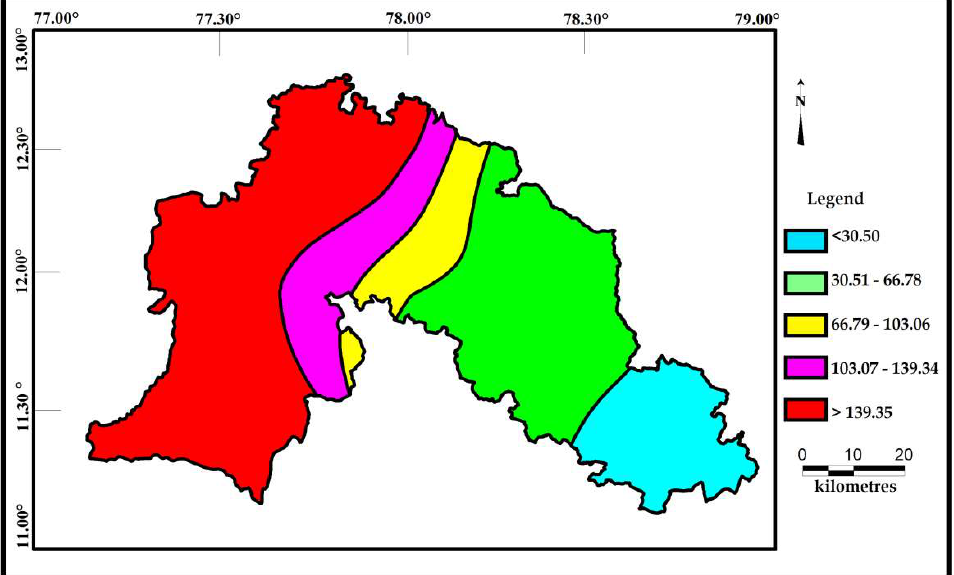
Figure 7. Spatial distribution of HPI for the samples collected in the study area.